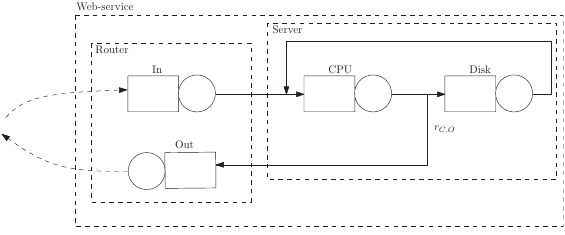
Figure 8: Queuing network representing a